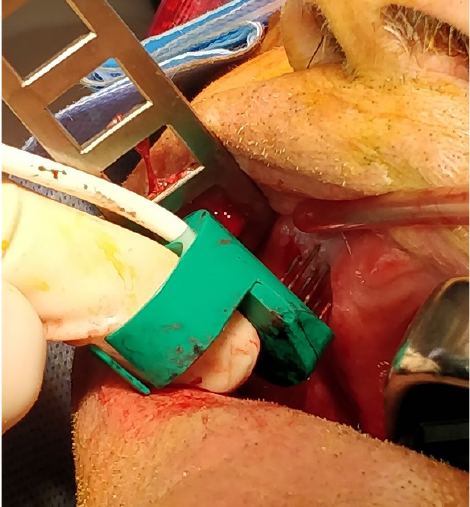
Figure 1. “Finger” electrode used for the delivery of electrical impulses.